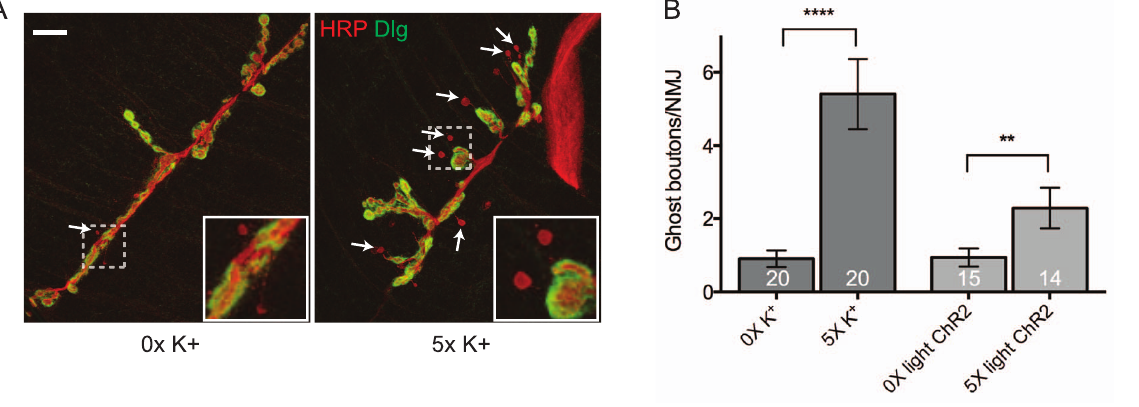
Figure 1. Acute spaced stimulation induces the formation of undifferentiated ghost boutons. (A) A representative Canton S third-instar NMJ at larval muscle 6/7 in abdominal segment 3 that was double stained with antibodies against the presynaptic membrane marker, horseradish peroxidase (HRP; red) and postsynaptic discs large (DLG; green) after being subjected to 0x (control) or 5x high K + (90 mM) spaced depolarization. Arrows point to ghost boutons (HRP + DLG-). Each inset corresponds to the indicated region (dashed box) and is blown up to help visualize ghost boutons (red HRP + presynaptic extensions). Scale bar=20 m M. (B) Quantification of the number of ghost boutons per NMJ in Canton S (high K + stimulated) or animals expressing the transgenic light-gated ion channel, ChR2, in motor neurons (light stimulated; the UAS-ChR2 line was crossed to C380-Gal4 ). These data are highly consistent with published results [12,14,15]. 1–2 unpaired NMJs per larval treatment group. Error bars indicate the mean 6 SEM. STATISTICS: Student’s t-test. ** p , 0.01 and **** p ,